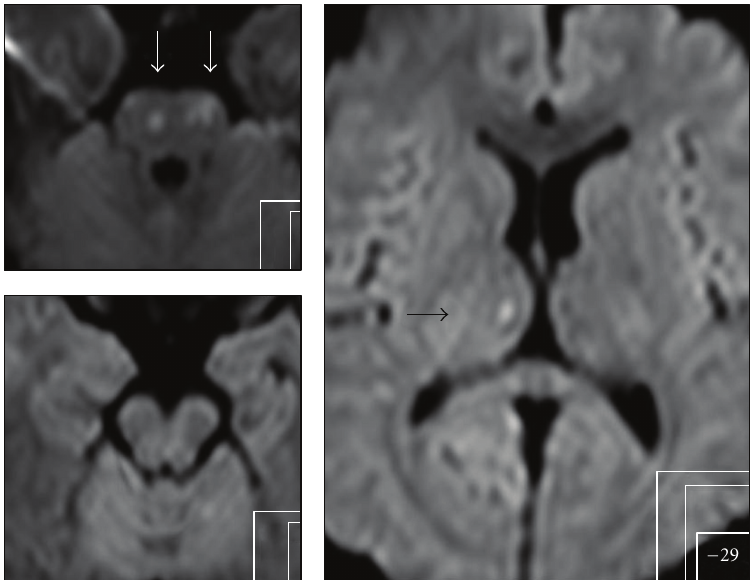
Figure 4: Very few DWI lesions in follow-up MRI 24 h after symptom onset in pons (white arrows) and in the right thalamus (black arrow) and no neurological deficit.